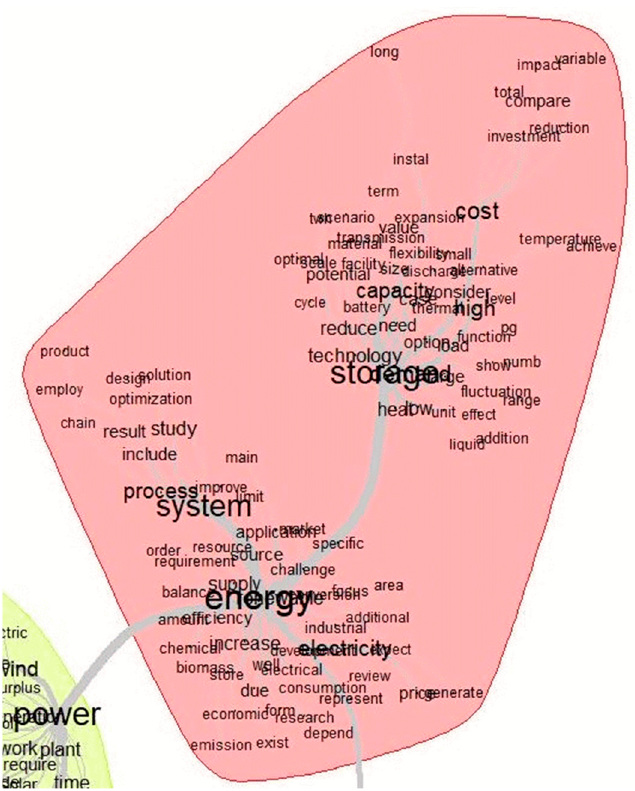
Figure 5. The set of words focused around the word “energy”. Source: own elaboration based on an analysis in the IRAMUTEQ software.